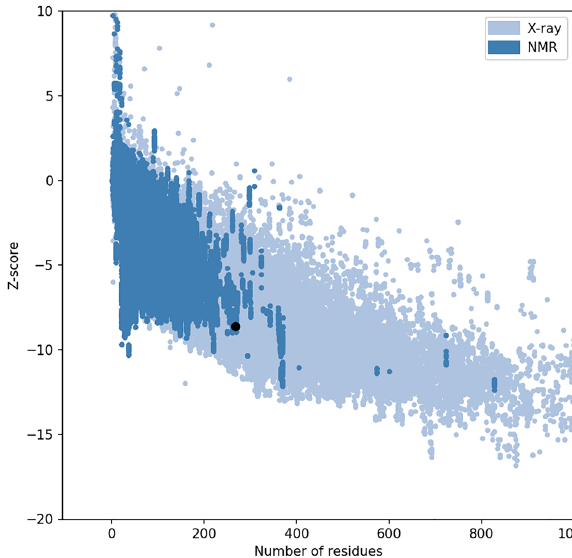
Figure 2: Quality (Z) score of homology model of polymorphic PPARA.